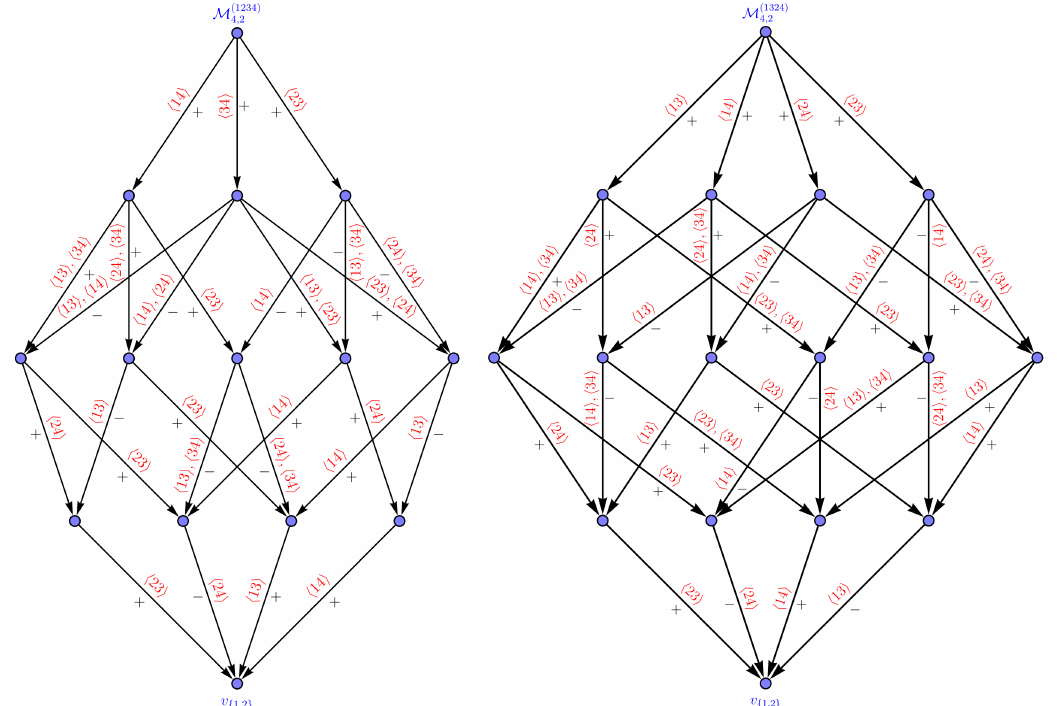
(left) and M (1324) (right), and the 4 , 2 4 , 2